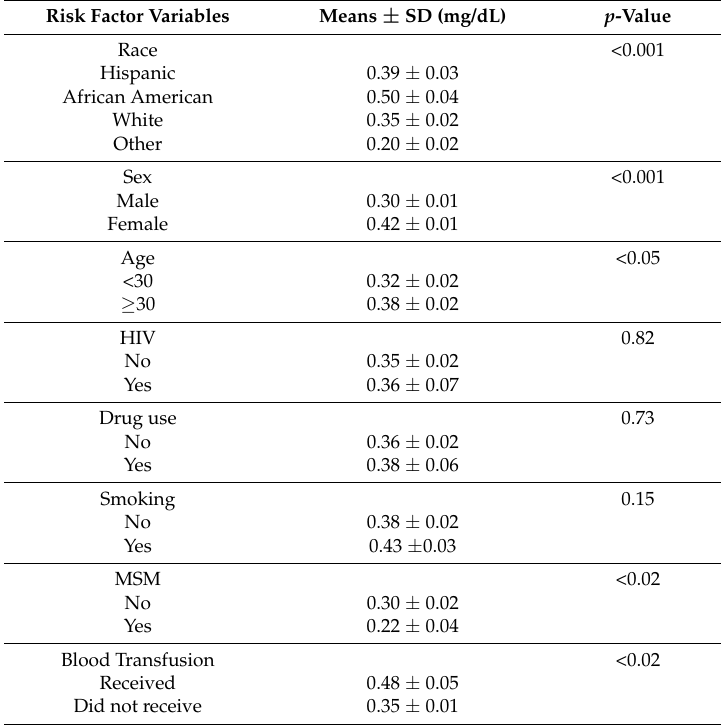
Table 3. C-reactive protein (CRP) levels by Risk Factor